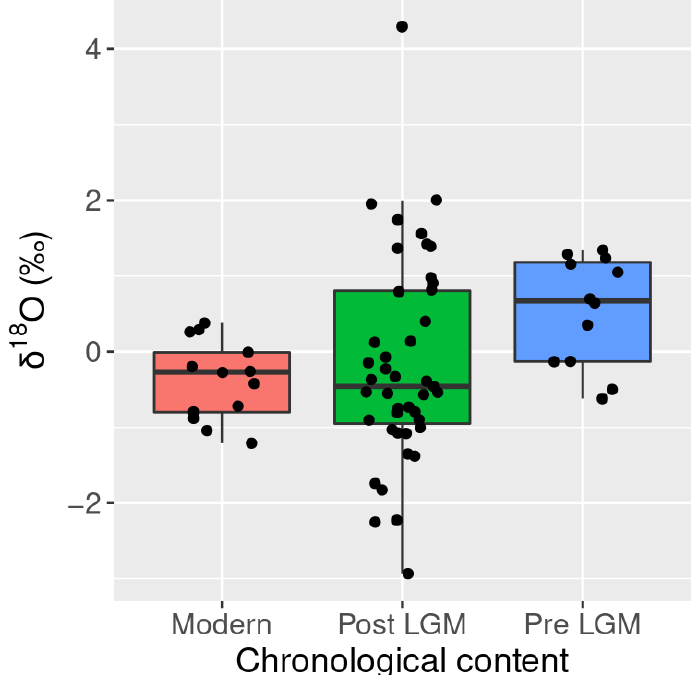
Figure 10. Box plot L. conspicillatus and O. robustus δ 18 O by climatic period.